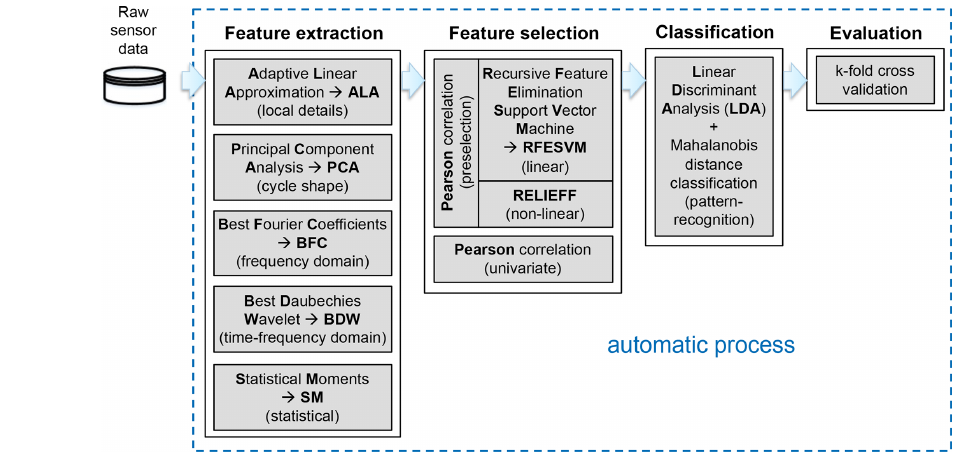
Figure 3. Schematic of the automatic toolbox for condition monitoring using machine learning, adapted from Dorst et al.